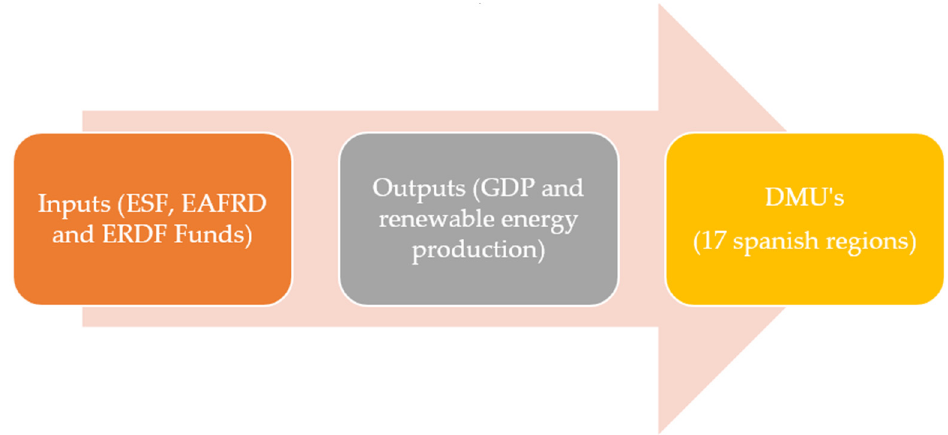
Figure 4. Summary of the applied methodology. Source: Authors’ own elaboration. The DMUs used are shown in Table 4. Table 4. DMUs used and level of development.